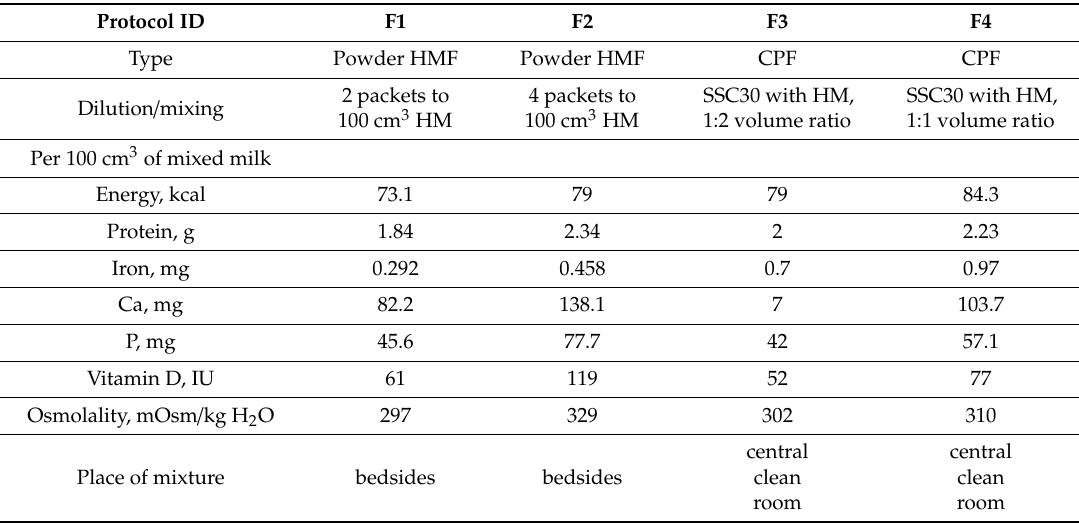
Table 1. Comparison of the nutrient contents of powdered human milk fortifier (HMF) and concentrated preterm formula (CPF) mixed with human milk under di ff erent mixing